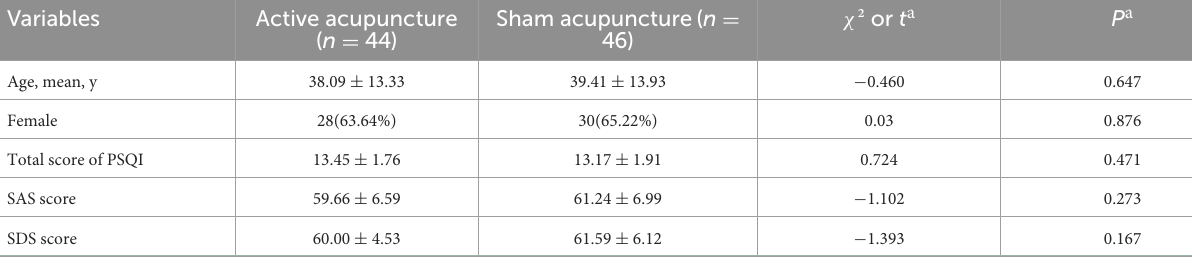
TABLE 2 Baseline